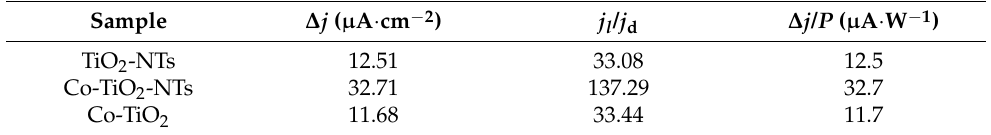
Table 3. Determined photoresponsivity values from Figure 9, where: ∆ j is the difference between the current registered for a sample in the dark and under its illumination, j l / j d is the ratio between the current registered for a sample in the dark and under its illumination, and ∆ j/P (photoresponsivity) is the ratio between photocurrent and light source optical power.